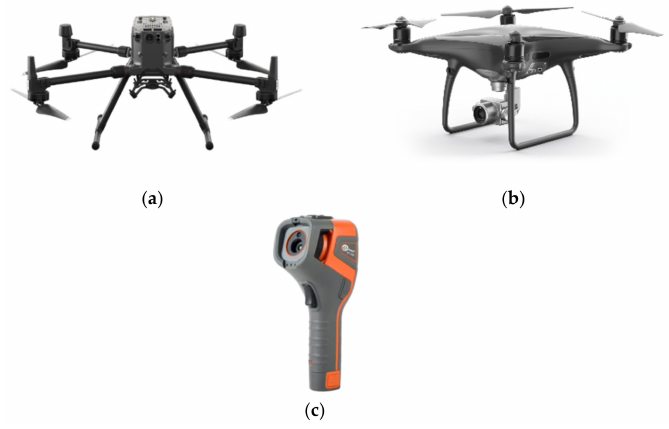
Figure 1. ( a ) Matrice 300 RTK, ( b ) Phantom 4 PRO, ( c ) KT-165.